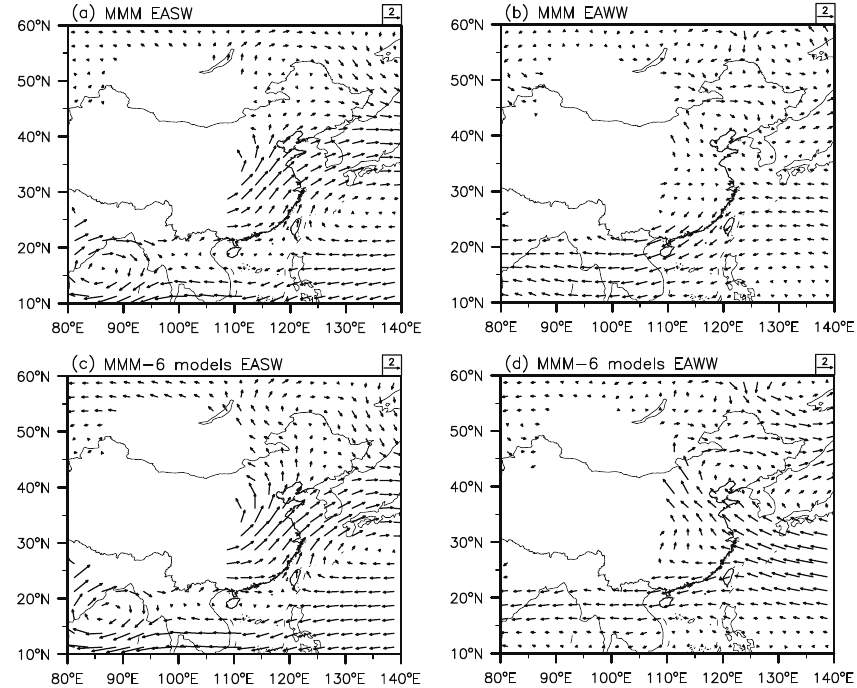
Fig. 4. The MMM for EASW (left column, units: ms − 1 ) and EAWW differences (right column, units: ms − 1 ) between mid-Pliocene and pre-industrial experiments. (a) and (b) are the MMM of all models; (c) and (d) are the MMM of the six models that simulate the weakened EAWW listed in Table 3. Regions with an elevation above 1500m are left blank.